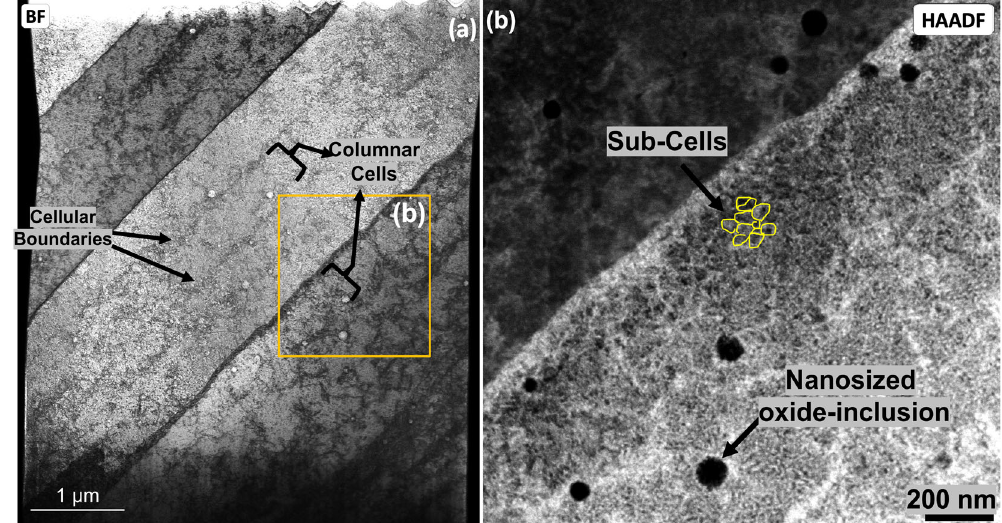
Fig. 3 STEM micrographs of SLM-316L/CrN. a BF image revealing the columnar cellular structure with cells and cell boundaries. b HAADF image showing the nanosized oxide-inclusions and sub-cells.